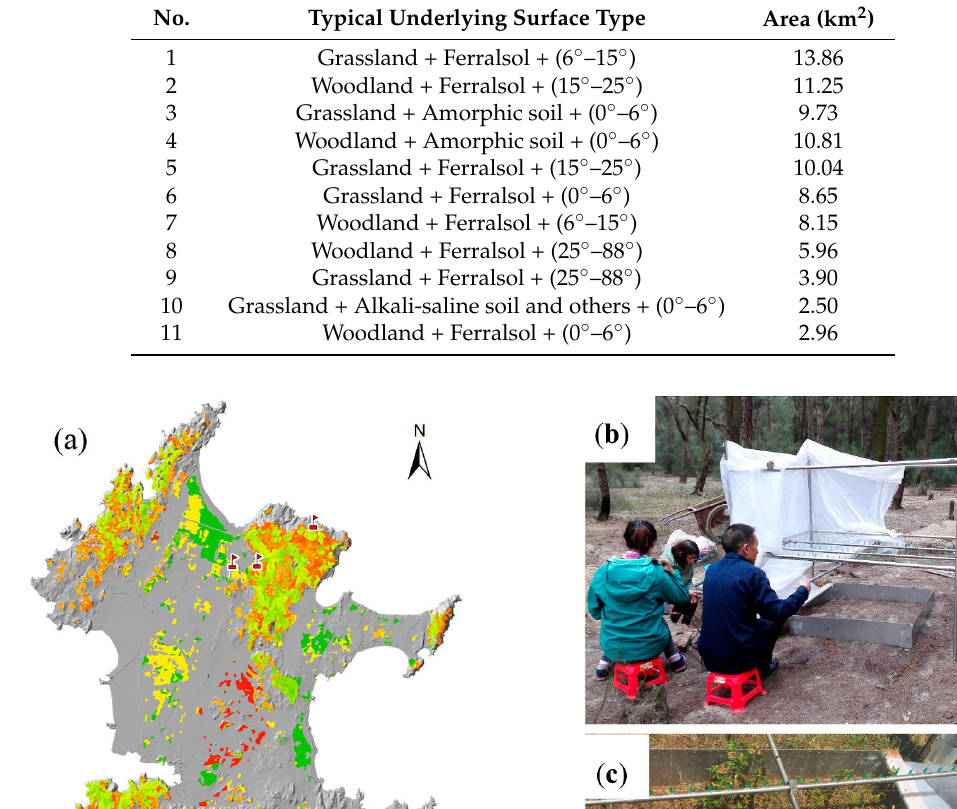
Table 1. Typical underlying surface types and their areas.